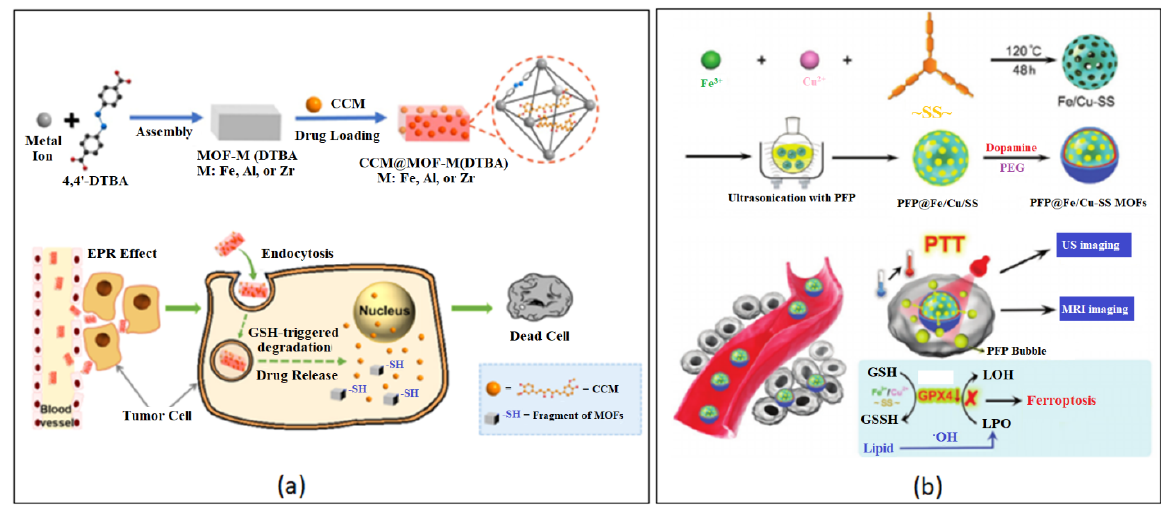
Figure 11. Examples of redox-responsive chemically modified BioMOF nanostructures. ( a